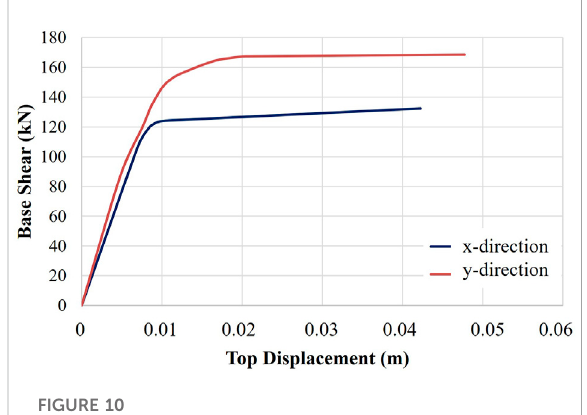
FIGURE 10 Obtained pushover curves both in x- and y-direction.